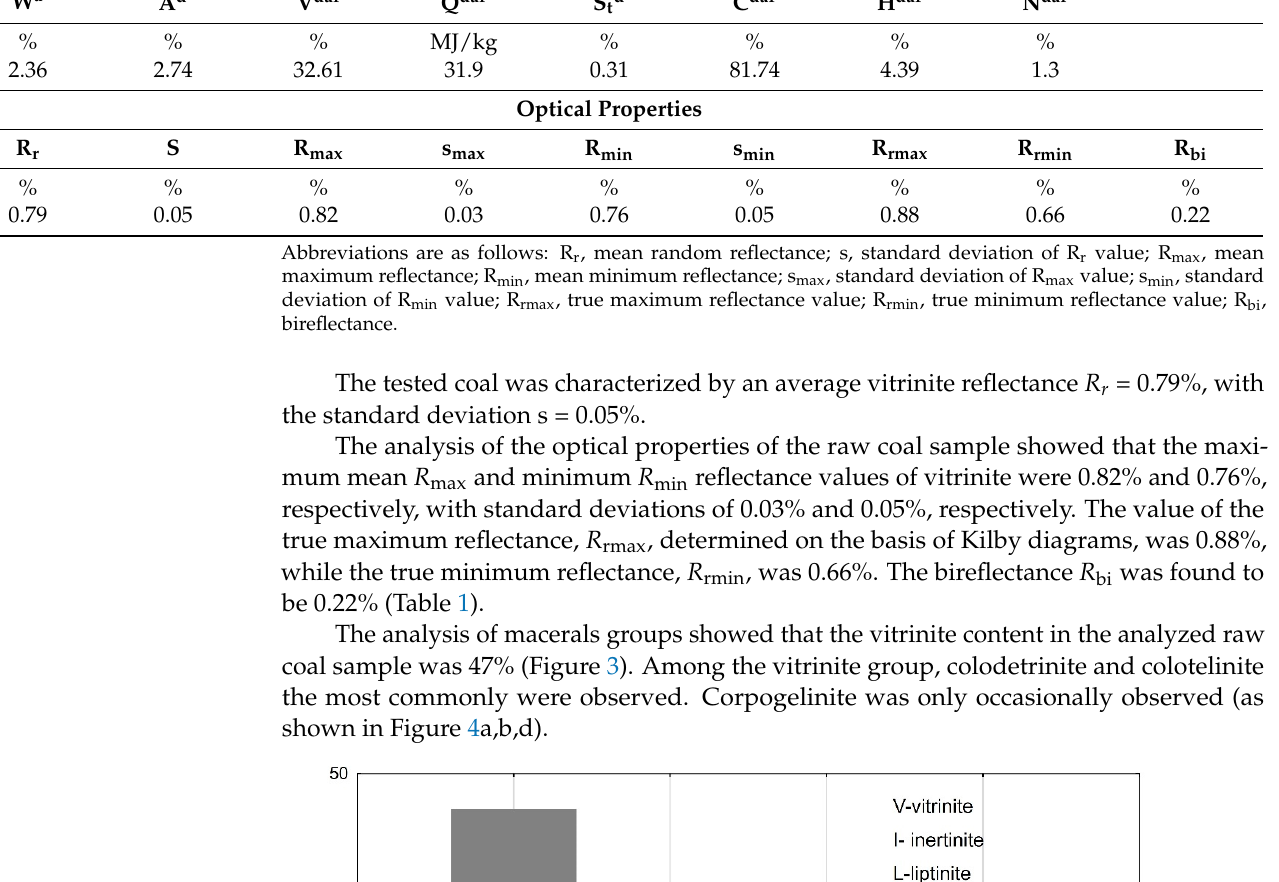
Table 1. Chemical–technological properties and vitrinite reflectance of a raw coal sample.